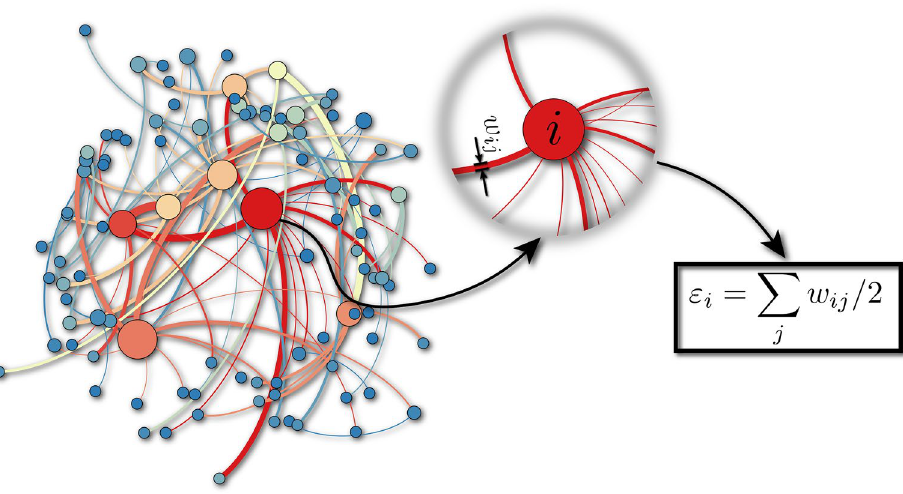
Figure 1. Sample of a N = 100 network for ( d , α A , α G , η , w 0 ) = ( 2, 1, 5, 1, 1 ) . As can be seen, for this choice of parameters, hubs (highly connected nodes) naturally emerge in the network. Each link has a specific width w ij and the total energy ε i associated to the site i will be given by half of the sum over all link widths connected to the site i (see zoom of site i